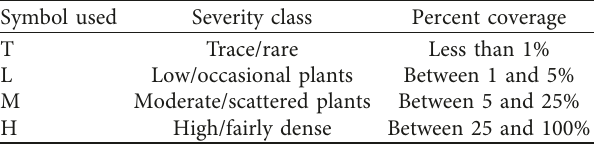
Table 1: Classification of severity of parthenium infestation. Symbol